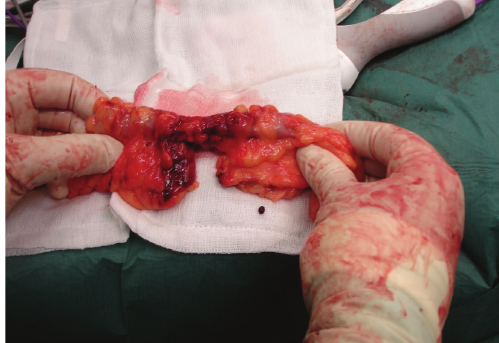
Figure 2: Intra-operative images from Case 1. Small bowel mesen- teric shearing injury with devascularisation resulting in small bowel